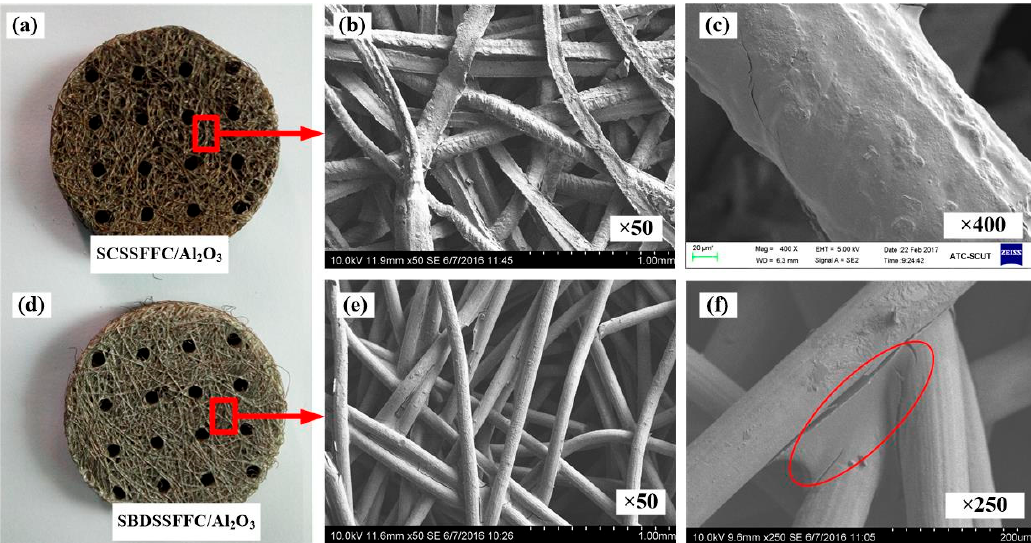
Figure 6. Different samples with Al 2 O 3 coating: ( a ) appearance of SCSSFFC/Al 2 O 3 ( b , c ) SEM of SCSSFFC/Al 2 O 3 ; ( d ) appearance of SBDSSFFC/Al 2 O 3 ; ( e – f ) SEM of SBDSSFFC/Al 2 O 3 .